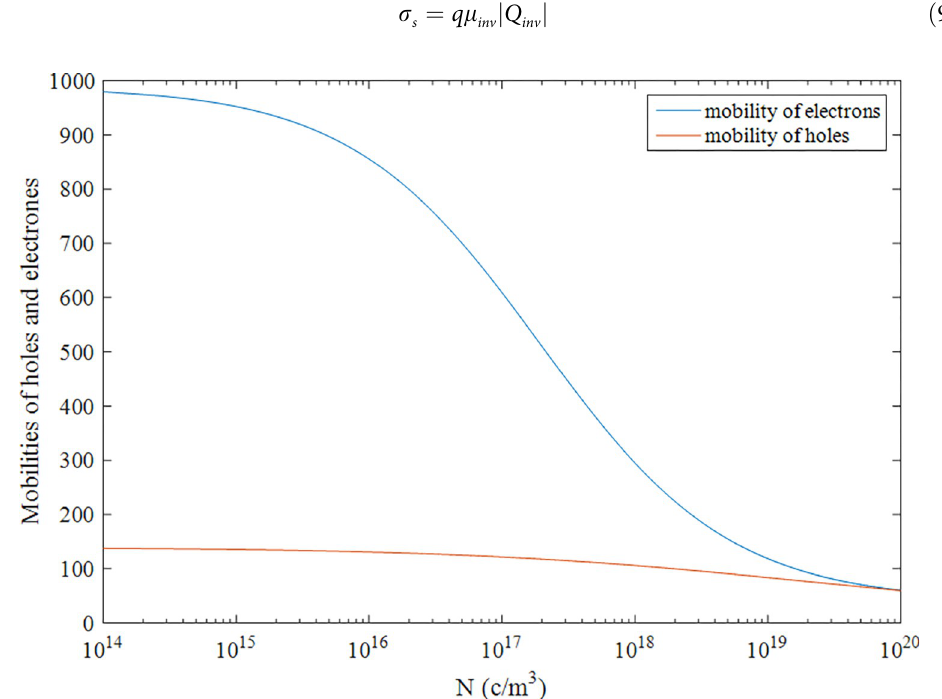
Fig 2. Electrons and holes mobility as a function of doping